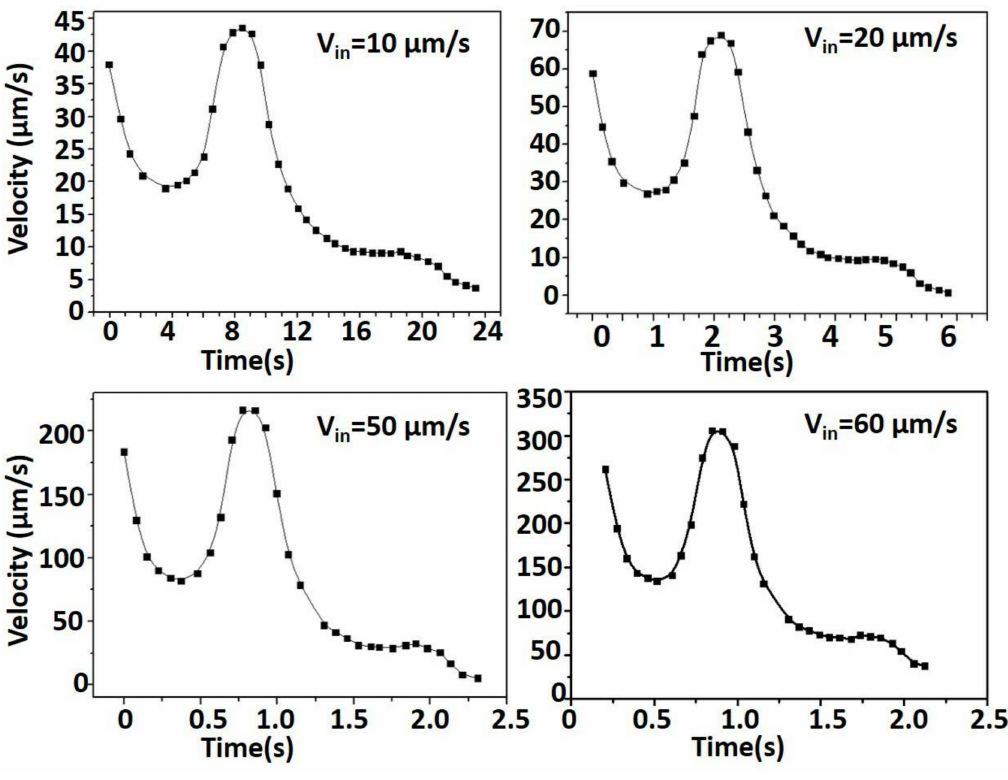
Figure 6. The change of velocity of the microsphere.